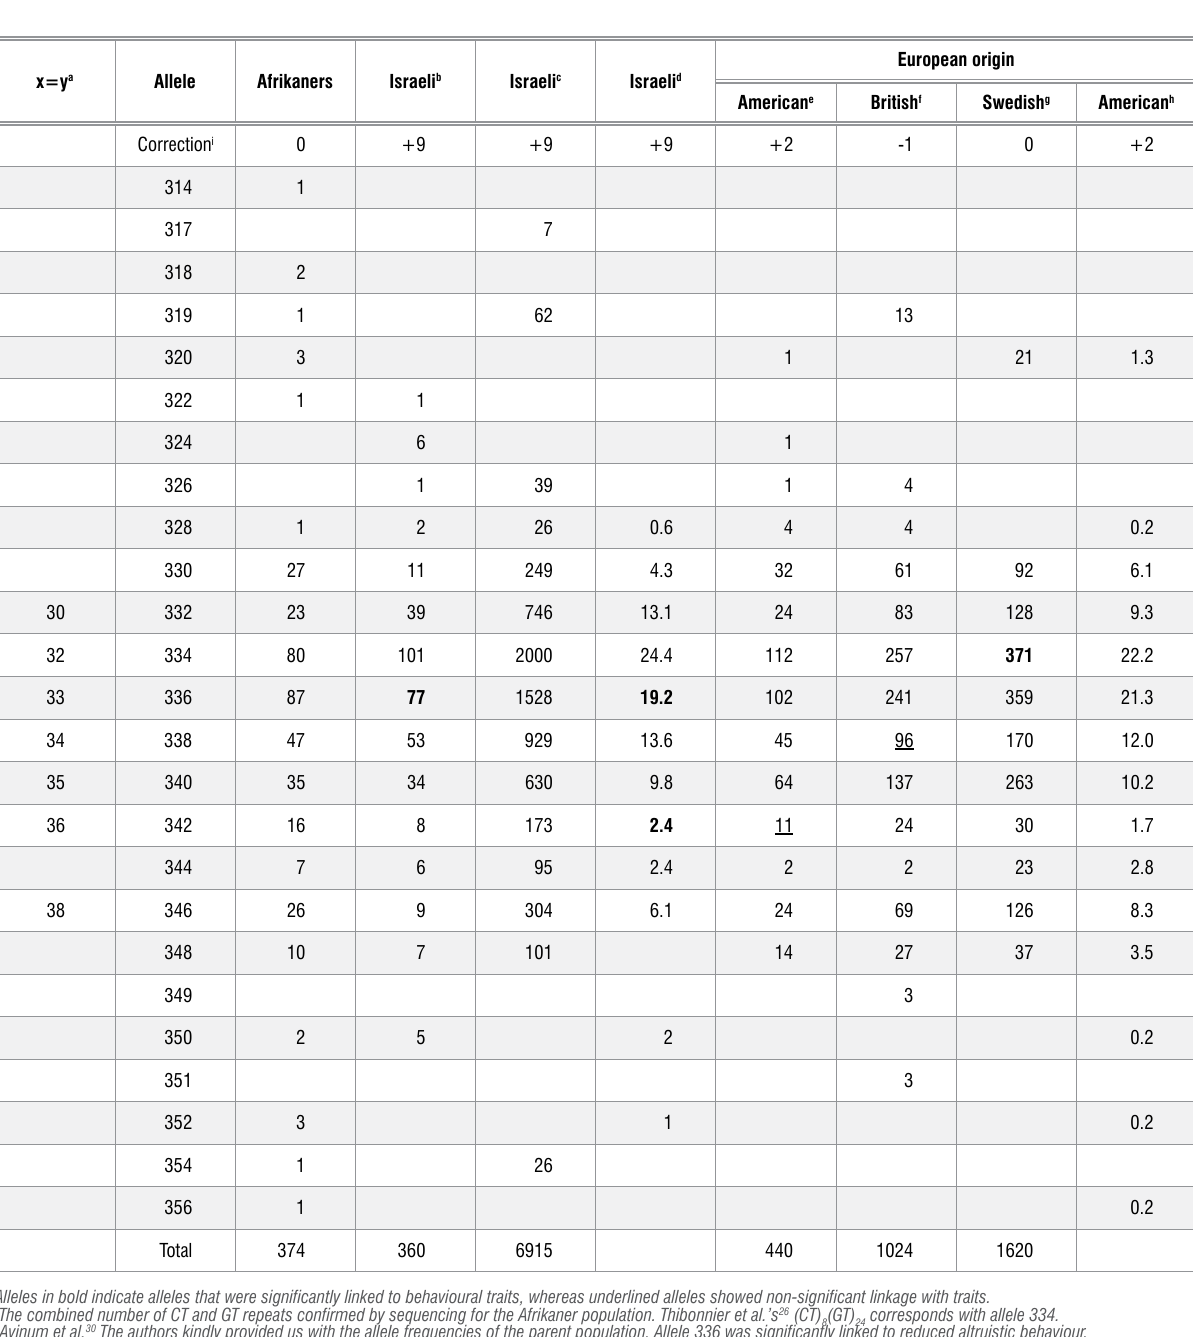
Table 2: Allele frequencies at the AVPR1A RS3 locus for the Afrikaner and seven other populations